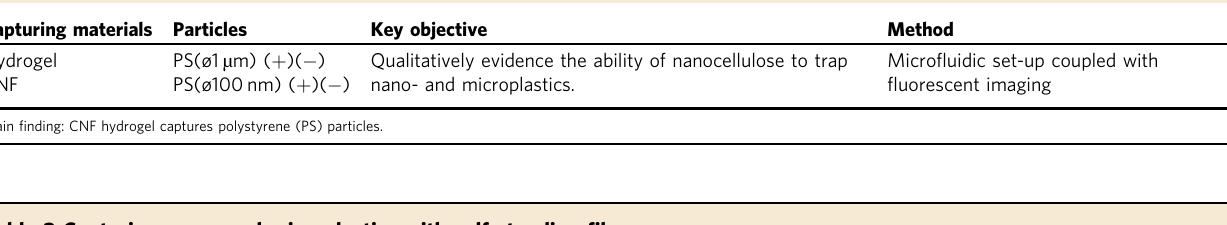
Table 3 Capturing nano- and microplastics with self-standing fi